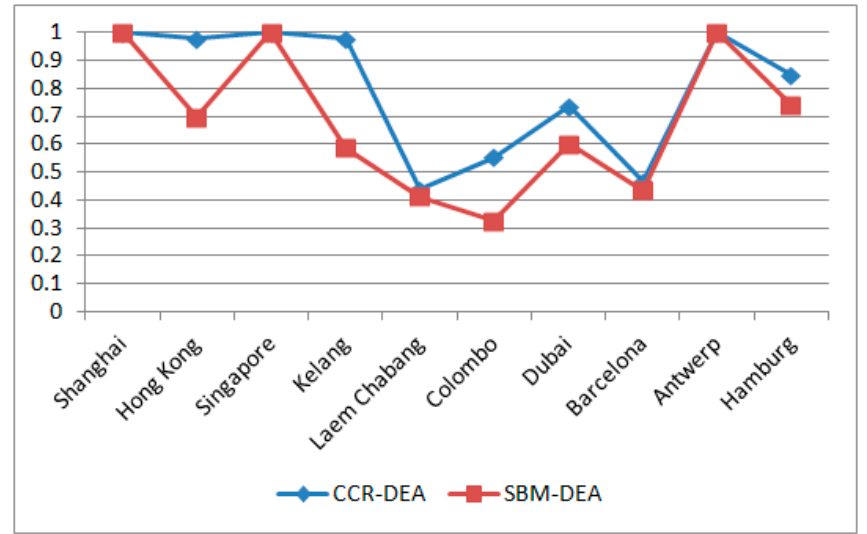
Figure 2. Comparison of the operational efficiency (CCR-DEA) and the environmental performance (SBM-DEA) of the 10 container ports along the MSR.